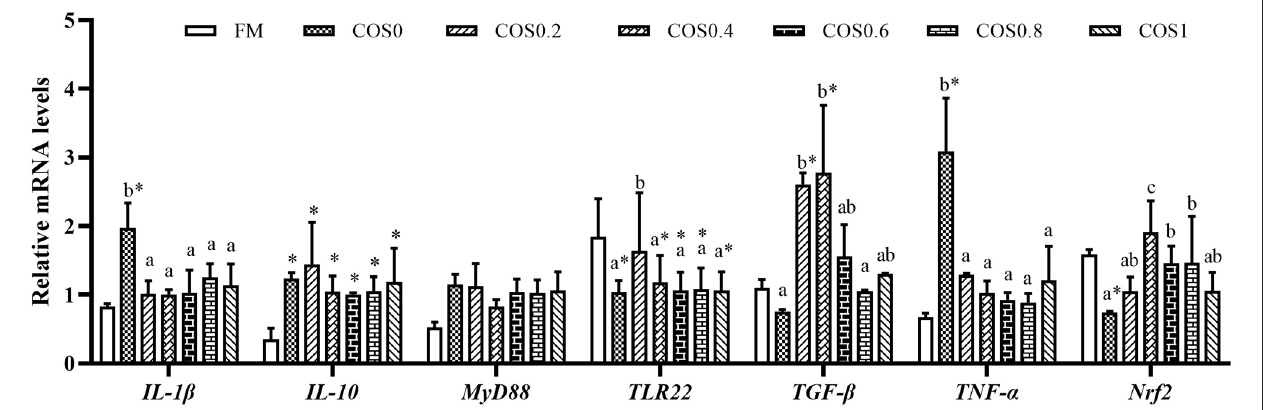
FIGURE 8 | Intestinal immunity gene expression of hybrid grouper fed with experimental diets for 8 weeks. Values are means ± SEM ( n = 3). Values in the same row with different superscript letters mean significantly different among COS-containing groups ( P < 0.05). The superscript * indicates that this COS-containing group is significantly different from FM group ( P <